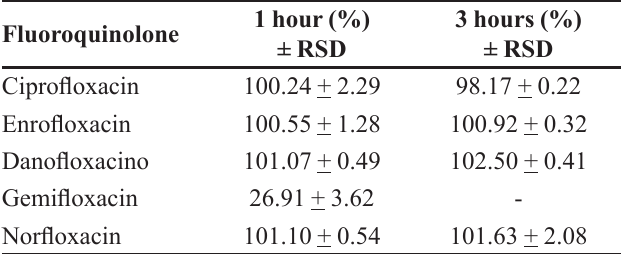
TABLE III - Degradation forced studies for fluoroquinolones using UVC radiation (254 nm) Fluoroquinolone